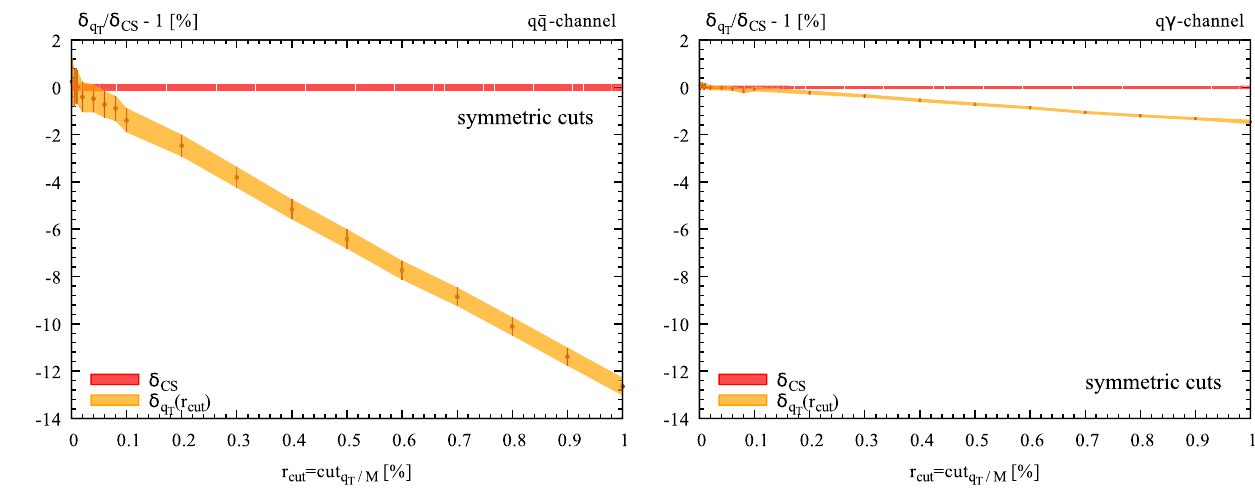
Fig. 2 NLO EW correction as a function of r cut in the dominant qq diagonal channel (left panel) and in the off-diagonal q ( ¯ q )γ channel (right panel) at 14TeV. The NLO result is normalised to the r cut -